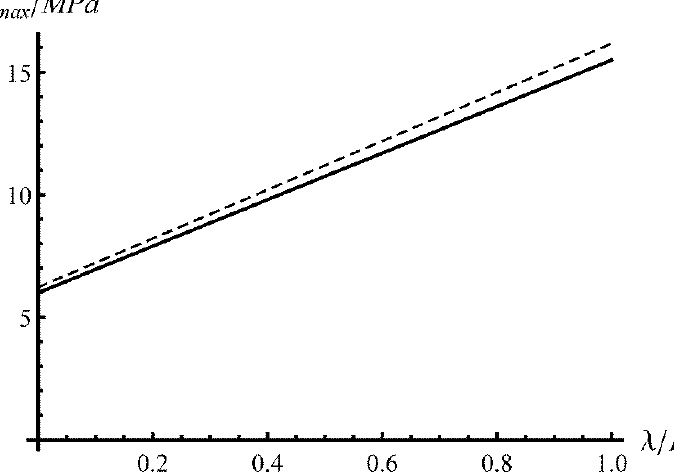
Figure 2. Stress–strain curves according to Equations (35) and (36): ( a ) copper alloy, ( b ) aluminum alloy. The solid curves correspond to Equation (35) and the broken curves to Equation (36).